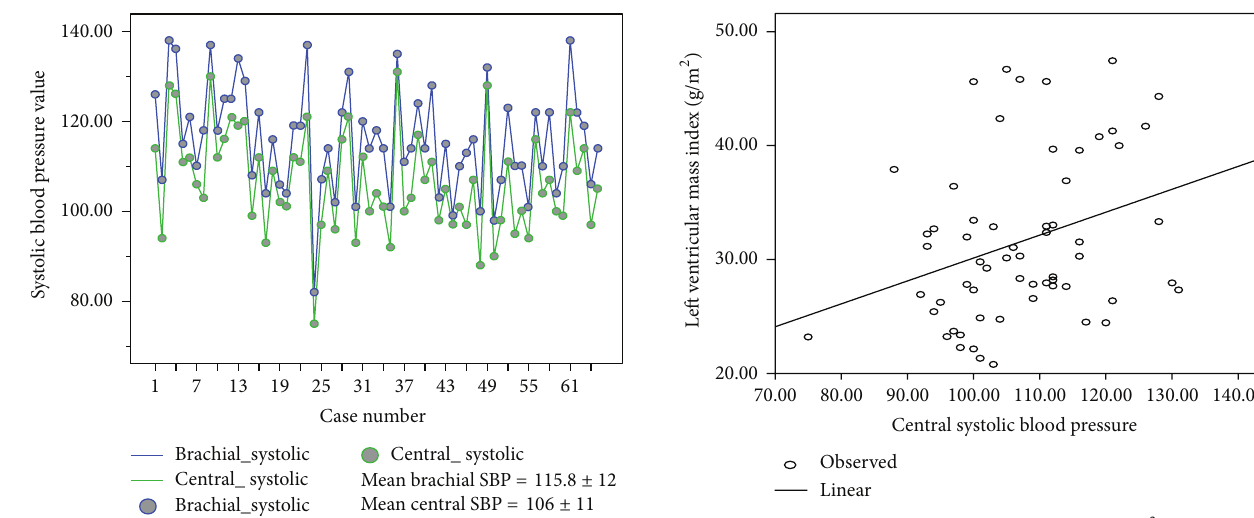
Figure 5: Correlation between LV mass index (kg/m 2 ) and central systolic blood